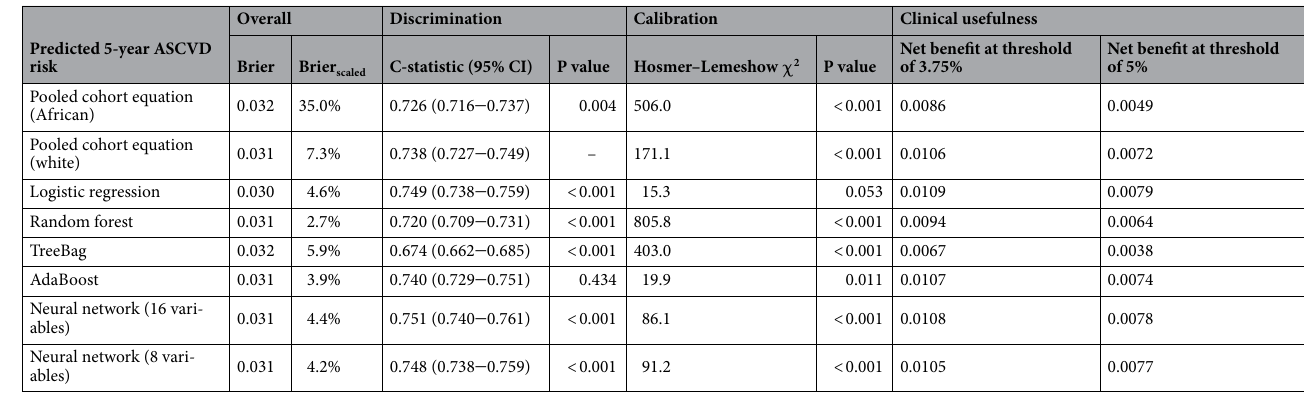
Table 2. Performance of machine-learning based risk prediction models in the test set of the pooled cohort equation cohort. ASCVD atherosclerotic cardiovascular disease, CI confidence interval.